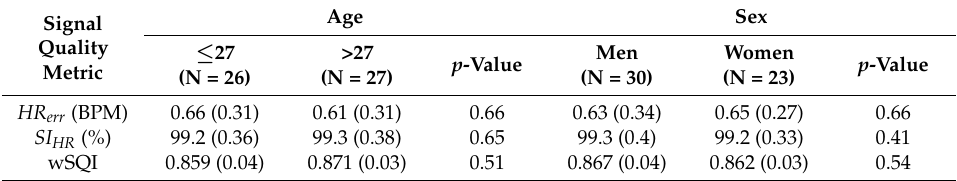
Table 7. Wilcoxon rank-sum test results and mean (SD) signal quality metrics of different groups.